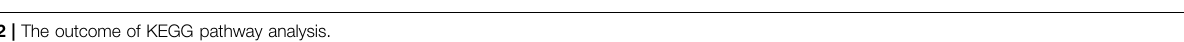
TABLE 2 | The outcome of KEGG pathway